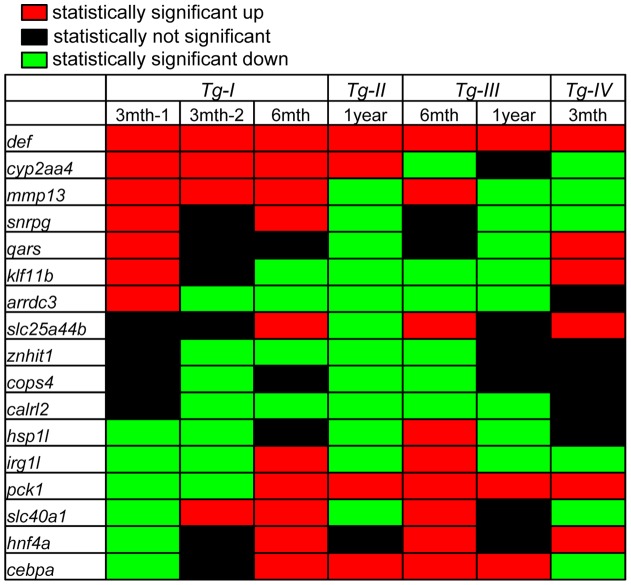
Summary of the expression changes of the 16 genes in the adult livers of four transgenic lines with respect to that in the WT liver.The summary was based on the qPCR data shown in Figure 7. Notably, the data showed that the expression of these 16 genes in Tg-II+/−, Tg-III+/− and Tg-IV+/− did not follow the trend or even opposite changes when compared with that observed in Tg-I. Surprisingly, the expression of these 16 genes in different batches of Tg-I at the same age were also different.